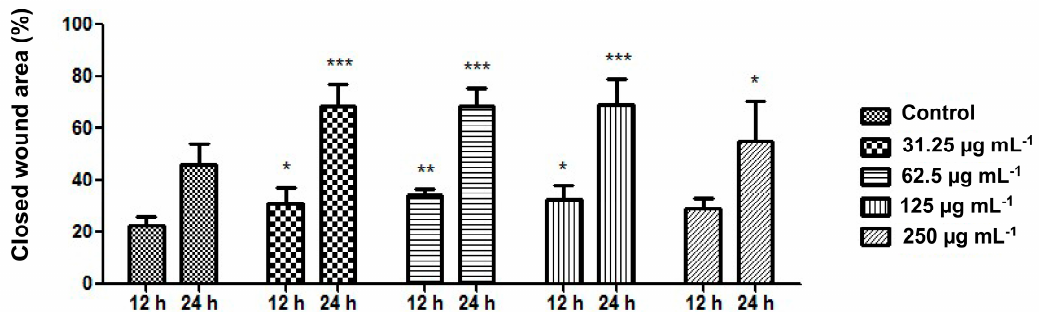
Figure 1. E ff ect of the di ff erent concentrations of Calendulae flos lyophilized extracts on the closed Figure 1. Effect of the different concentrations of Calendulae flos lyophilized extracts on the closed wound area. Results are expressed as means ± SD. Statistical significance was designated at (*) P < 0.05; wound area. (**) P < 0.01; (***) P < 0.001 (versus control at respective time point) using ANOVA followed by Bonferroni’s post hoc